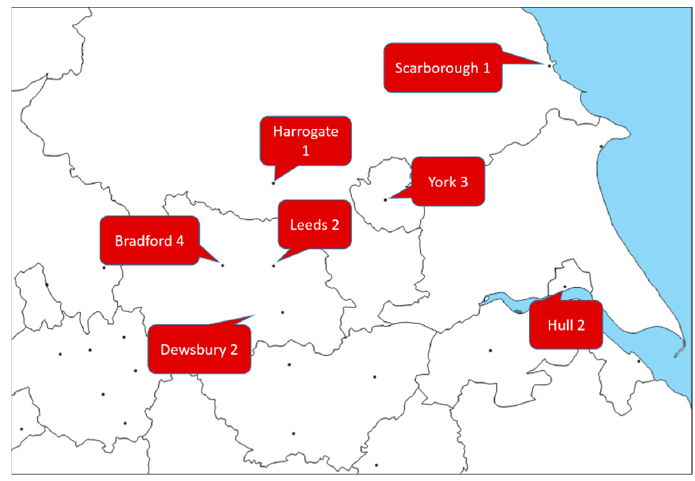
Figure 1. Map highlighting the distribution of new-onset myositis cases across the Yorkshire region, adapted from https://d-maps.com/carte.php?num_car=18610&lang=en (accessed on 12 May 2022). Dewsbury and District Hospital is part of The Mid Yorkshire Hospitals NHS Trust, alongside Pinderfiels Hospital of